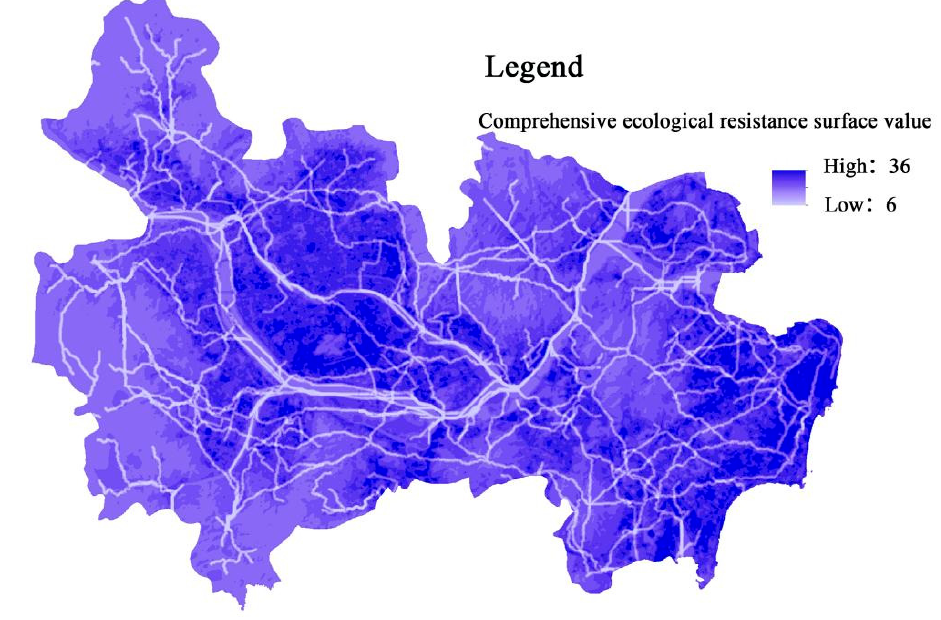
Figure 6. Comprehensive ecological resistance